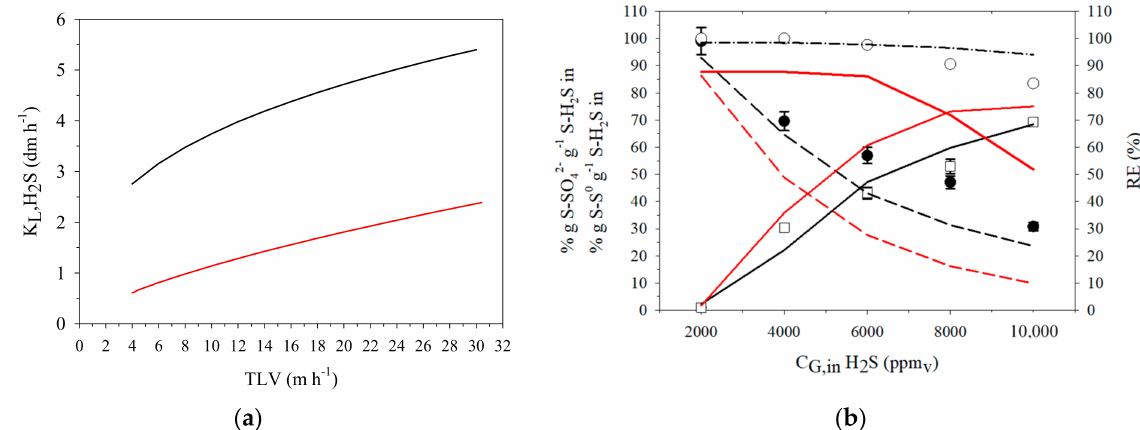
Figure 3. ( a ) Mass transfer coefficient as a function of the TLV using the Billet and Schultes correlation (dark solid line), Onda correlation (red solid line) and ( b ) Open-Loop performance as a function of the incoming H 2 S gas concentration. Experimental (o) and simulated (solid line) H 2 S removal efficiency. Experimental ( • ) and simulated (dashed line) sulfate selectivity: experimental ( (cid:3) ) and simulated sulfur selectivity. An additional comparison was made between the Billet & Schultes correlation (black) and Onda’s correlation (red). Further information about how experimental data from Figure 3B was obtained can be found in